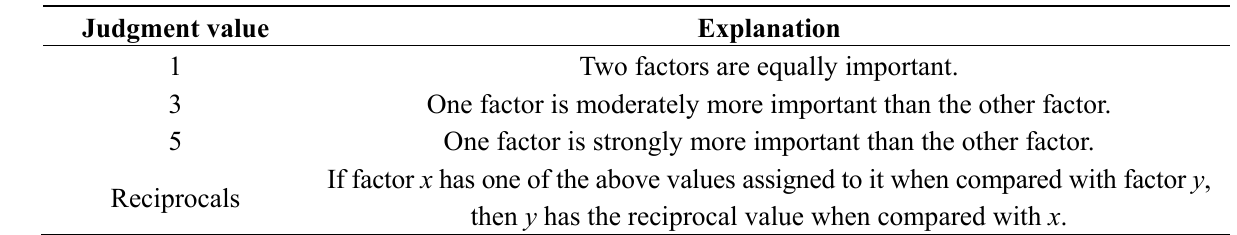
Table 1. The criteria of the judgment